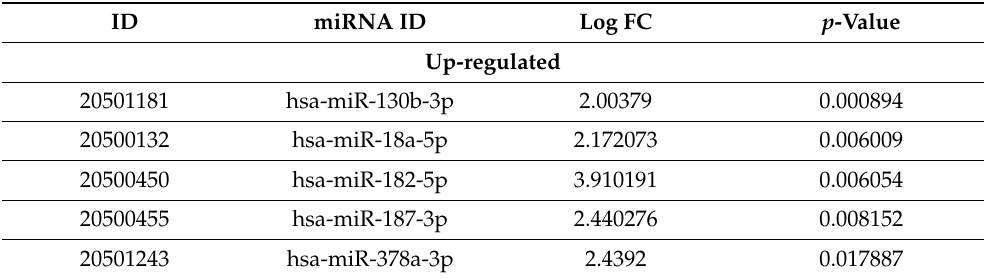
Table 1. The top five upregulated and top five downregulated miRNAs based on the logFc and p